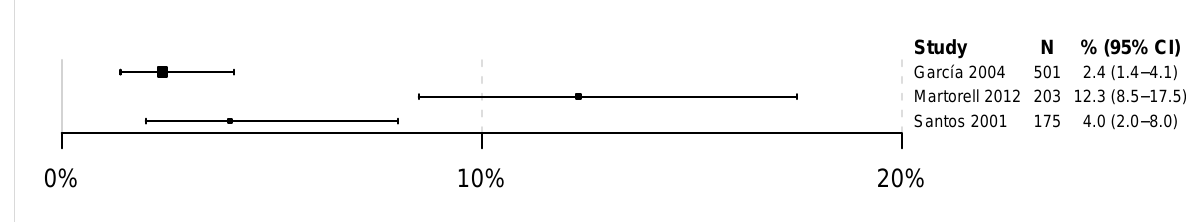
Figure 56: HPV 16 prevalence among women with normal cervical cytology in Peru, by